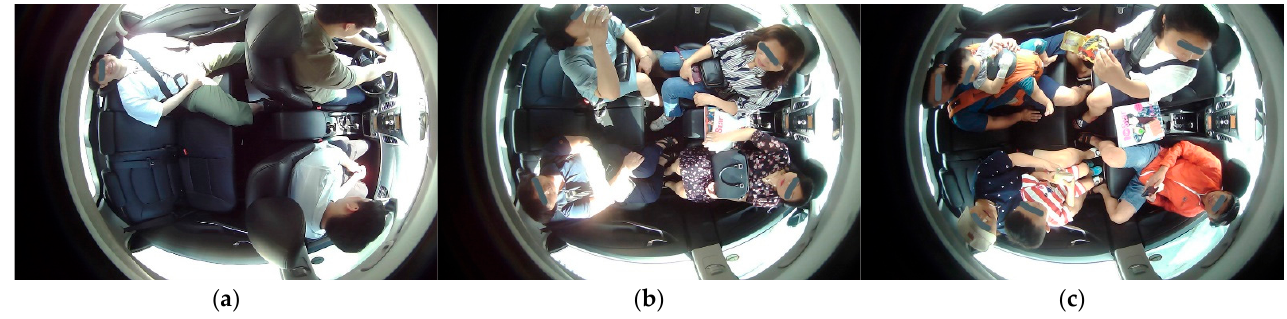
Figure 5. Example images of occupants captured for high levels of autonomous driving: ( a ) Images captured with one action at a time; ( b ) Images captured with multiple actions performed randomly; ( c ) Images of children and objects.